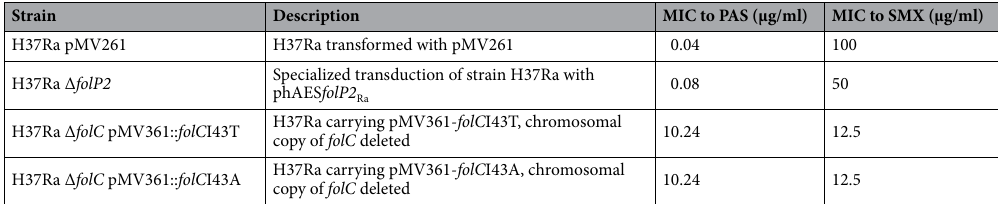
Table 4. PAS and SMX susceptibilities of different strains derived from M. tuberculosis H37Ra.